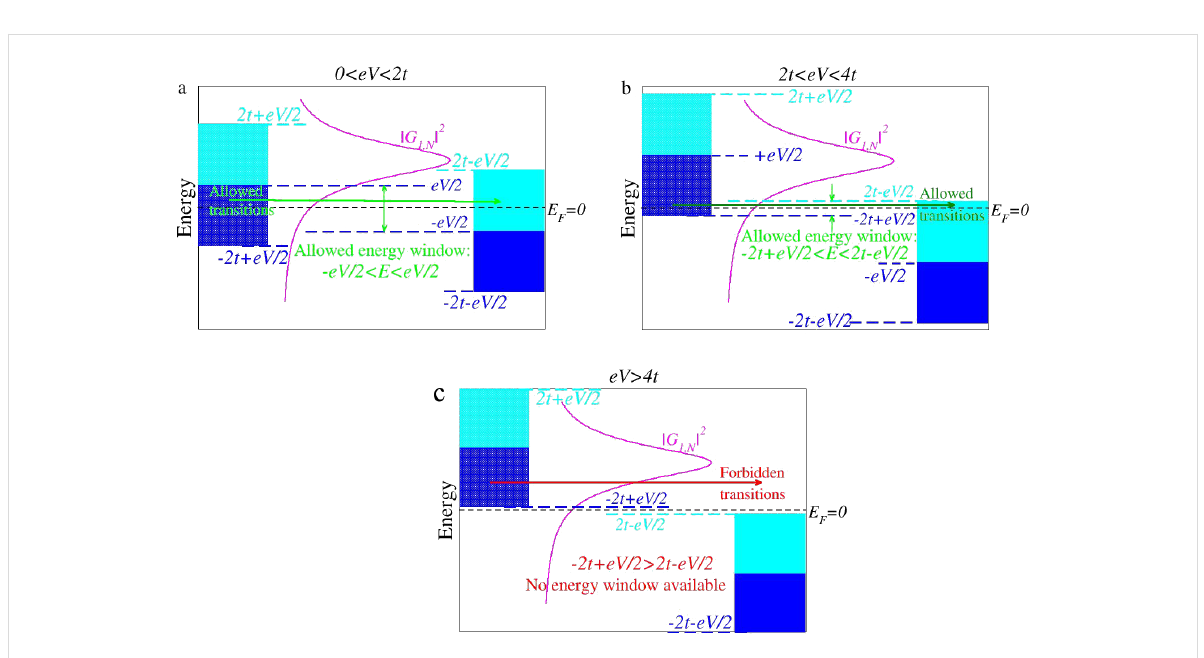
Figure 3: Schematic representation of the energy window available for elastic electron transitions at zero temperature ( t = | t L | = | t R |, V > 0). (a) At biases 0 < eV < 2 t , the (Fermi) energy window for allowed electron transitions becomes broader as the bias increases. (b) At biases 2 t < eV < 4 t , the energy window of allowed electron transitions ( − 2 t + eV /2 < ε < 2 t − eV /2) is narrower than the Fermi energy window ( − eV /2 < ε < eV /2); it becomes narrower as the bias increases. This is reflected in a current decrease, i.e., a negative resistance behavior. (c) The current vanishes for eV > 4 t , a bias range wherein there are no allowed electron